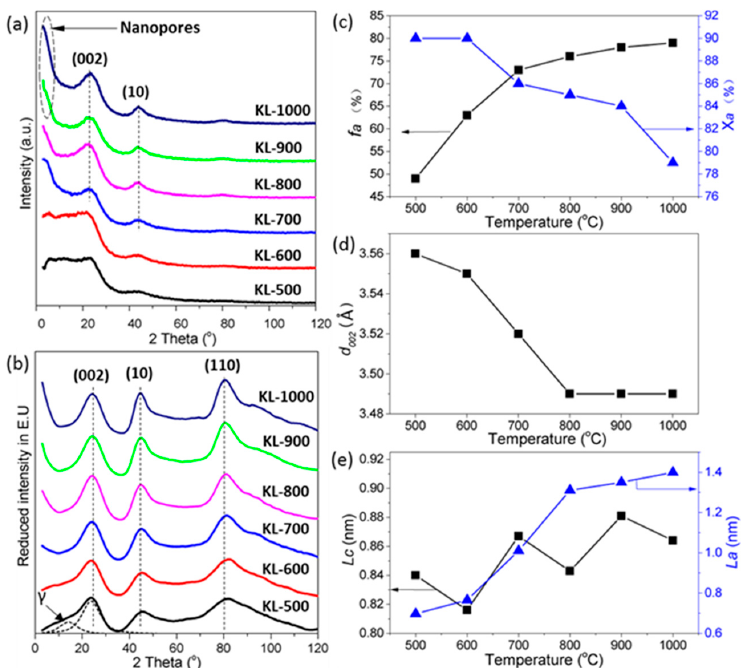
Figure 3. X-ray diffraction (XRD) analysis of KL-X samples: ( a ) wide angle (2 θ = 3~120 ◦ ) XRD patterns; and ( b ) reduced intensity XRD patterns; ( c – e ) the influence of heating temperature on the structural parameters of KL-X samples; ( c ) aromaticity f a and amorphous carbon fraction X a ; ( d ) interlayer spacing d 002 ; and ( e ) nanocrystallite lateral size L a and thickness L c . Table 2. Calculated structural parameters of KL-X samples from XRD, Raman, and HRTEM analysis. XRD Raman Sample